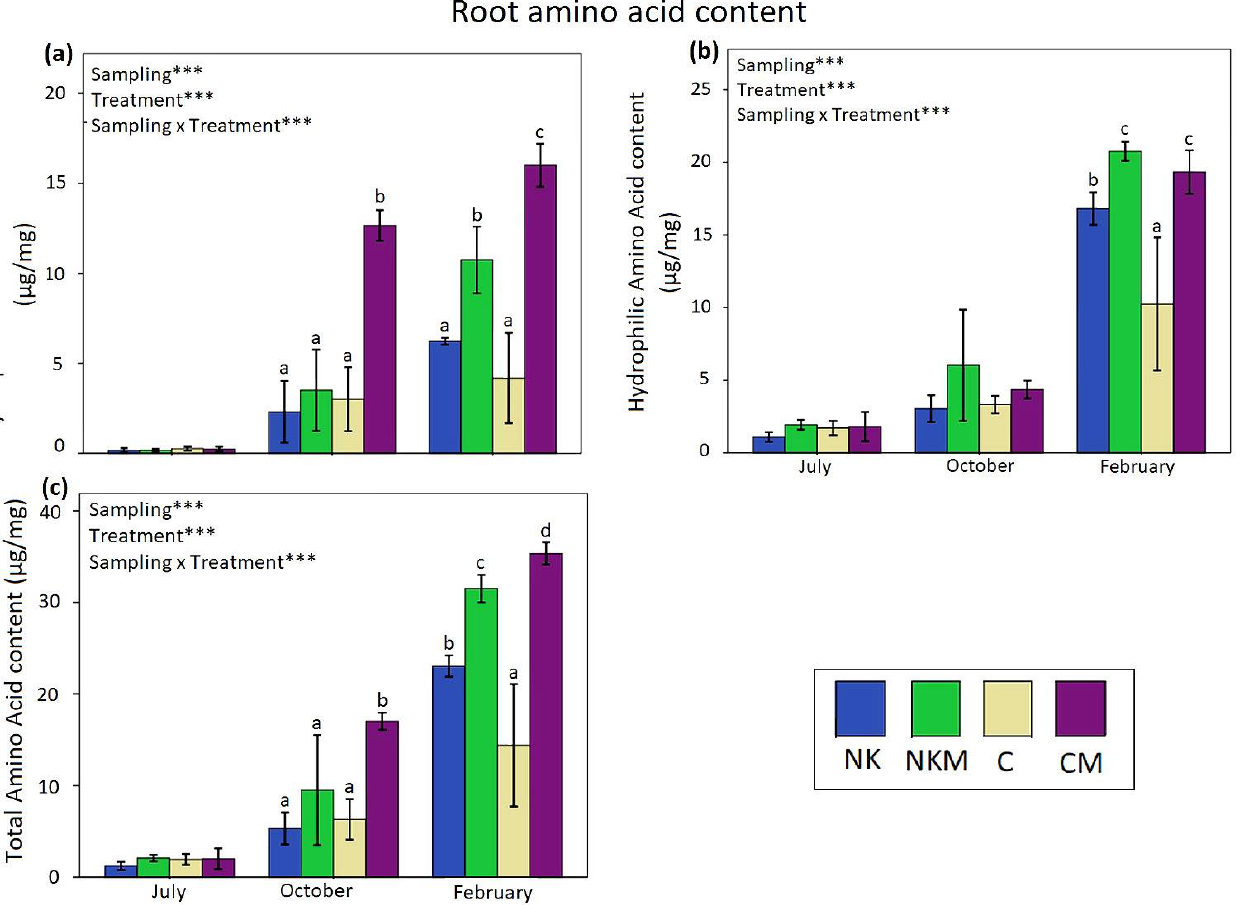
Figure 8. ( a – c ) Mean values ( ± SE) of root hydrophobic ( a ), hydrophilic ( b ) and total ( c ) amino acid content, as recorded in July, October and February samplings of all treatment groups (NK: KNO 3 fertilizer; NKM: KNO 3 in combination with PGPR; C (Control): NH 4 NO 3 fertilizer and CM: NH 4 NO 3 fertilizer in combination with PGPR). “Sampling”, “Treatment” and “Sampling × Treatment” on the top of the graphs indicate a significant effect of the sampling period, the treatment or their interactive effect, respectively, as revealed by ANOVA (*** p < 0.001). Different superscript letters denote significant differences between treatments (a: corresponds to the lowest